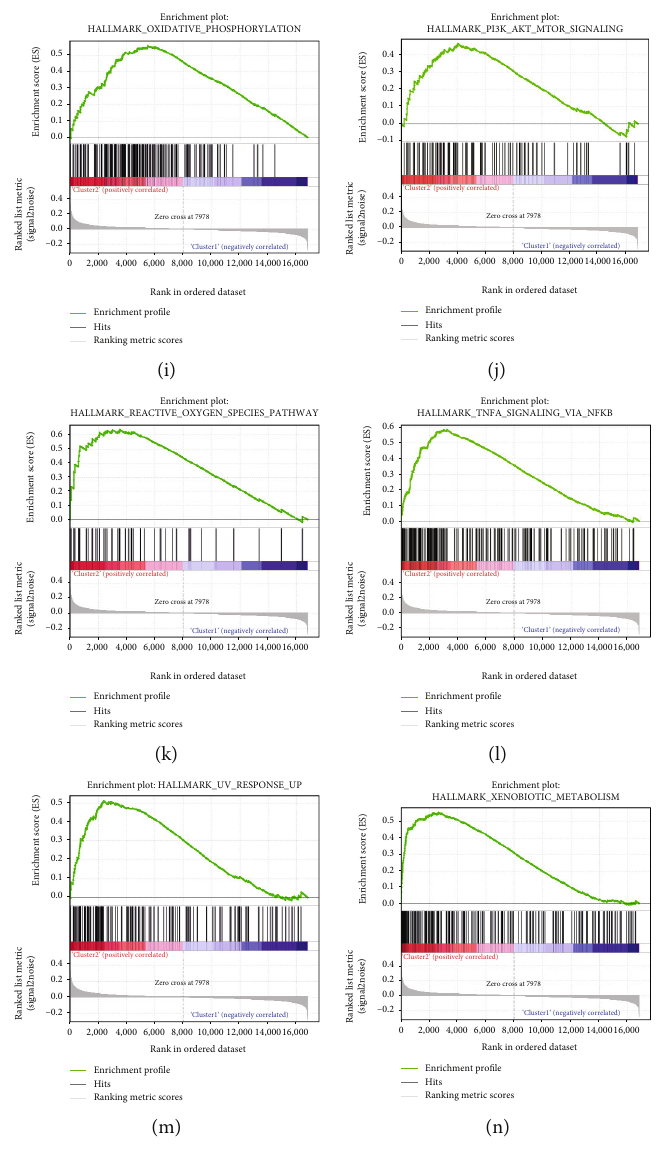
Figure 4: GSEA in adipogenesis subgroups. (a – n) Hallmark gene sets enriched in cluster 2 with a p value <